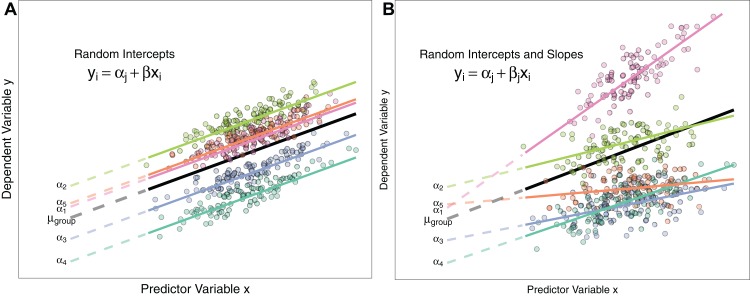
Differences between Random Intercept vs Random Slope Models.(A) A random-intercepts model where the outcome variable y is a function of predictor x, with a random intercept for group ID (coloured lines). Because all groups have been constrained to have a common slope, their regression lines are parallel. Solid lines are the regression lines fitted to the data. Dashed lines trace the regression lines back to the y intercept. Point colour corresponds to group ID of the data point. The black line represents the global mean value of the distribution of random effects. (B) A random intercepts and random slopes model, where both intercepts and slopes are permitted to vary by group. Random slope models give the model far more flexibility to fit the data, but require a lot more data to obtain accurate estimates of separate slopes for each group.